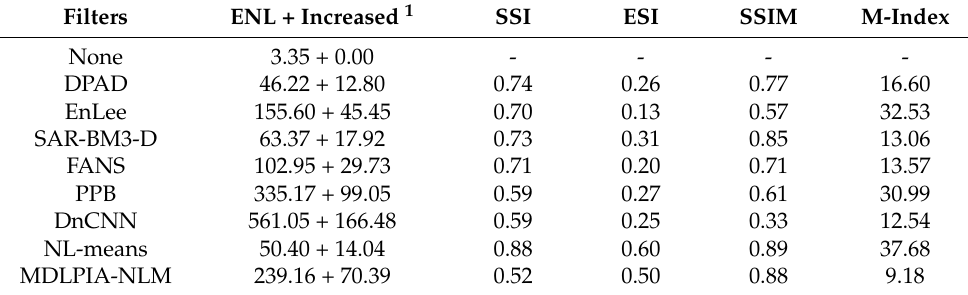
Table 5. Index evaluation for the RadarSAT-2 SAR